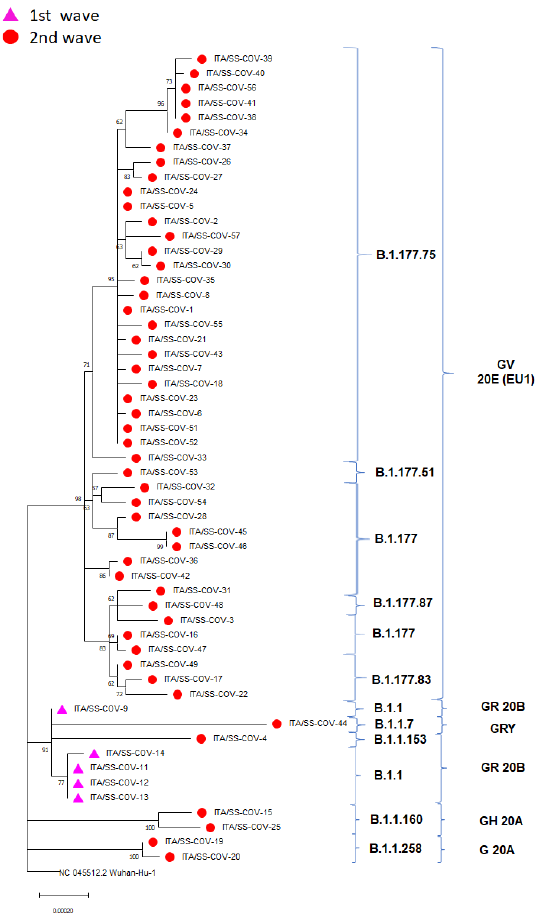
Figure 4. Maximum-likelihood phylogeny reconstructed using the Sardinian SARS-CoV-2 strains generated in this study. The tree is rooted to the SARS-CoV-2 reference genome Wuhan-Hu NC 045512.2. Purple triangles and red circles indicate sequences belonging to the first and second waves, respectively. SARS-CoV-2 clades and lineages are annotated using brackets.